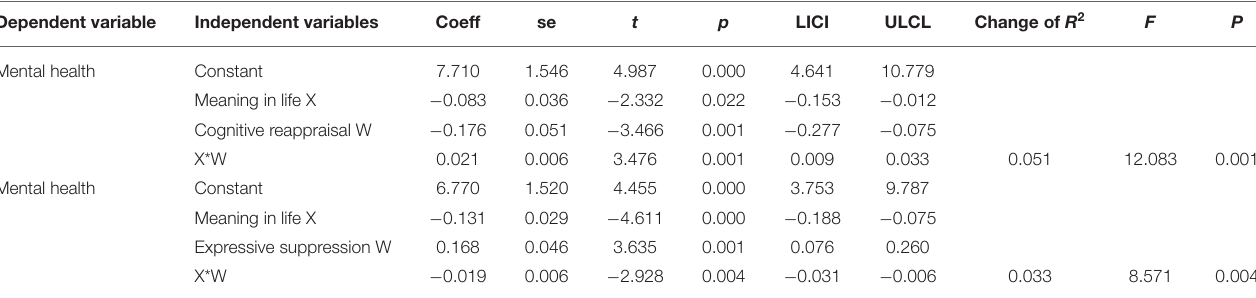
TABLE 2 | The moderating effect of emotion regulation in frontline nurses on meaning in life and mental health. Dependent